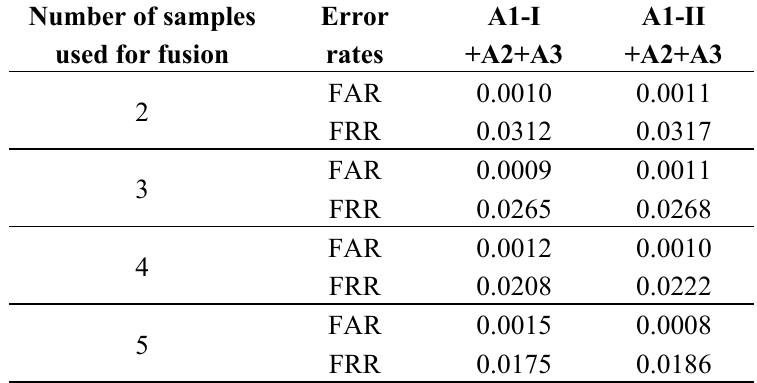
Table 7. Best performance (operation points closest to the performance target FRR ≤ 0.01 @ FAR = 0.001)—multi-sample-algorithm